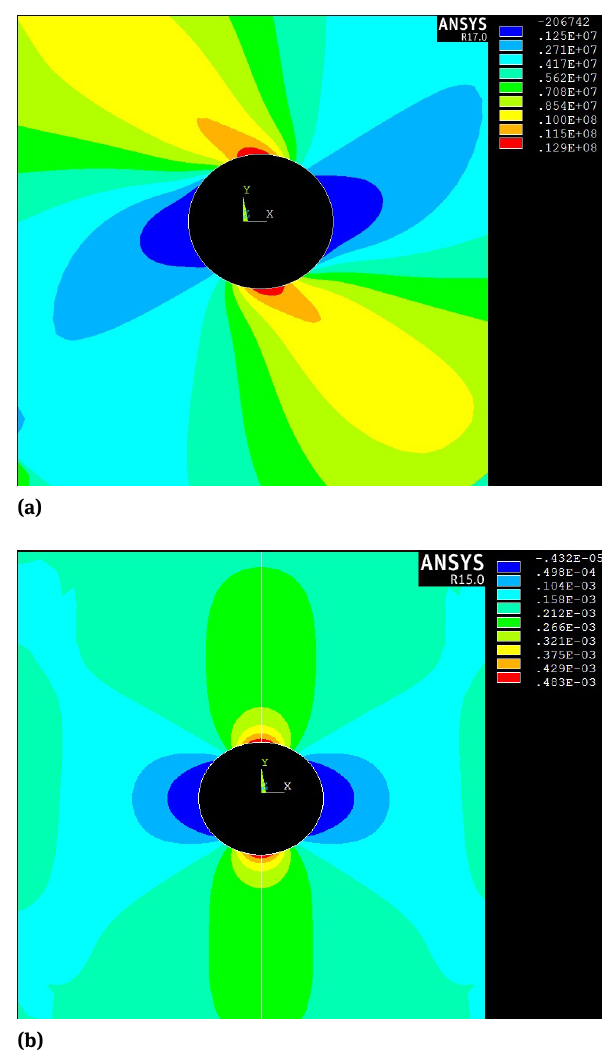
Figure 14: (a) Stress ( 𝜎 𝑥 ) and (b) strain distribution around hole for 45 ∘ fiber orientation